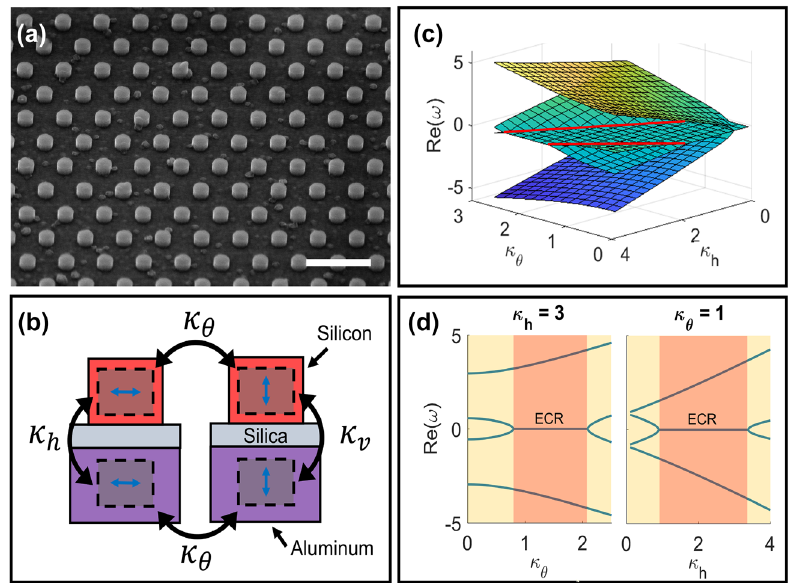
Figure 1: Ground plane system: coupling between horizontal and vertical modes unlocks topological effects. (a) Scanning electron microscope image of non-Hermitian metasurface (scale bar: 1 μ m). Silicon nanocylinders (radius = 120 nm, height = 120 nm) are arranged in a hexagonal lattice (lattice constant = 600 nm) on a silica spacer layer (variable thickness) and aluminum layer. (b) The metasurface contains horizontal and vertical photonic modes coupled to their respective image charges in the aluminum ground plane ( 𝜅 Horizontal and vertical modes can couple to each other by varying the angle of incidence of excitation ( 𝜅 𝜃 ). (c) Real part of eigenvalues for representative 4 × 4 Hamiltonian of the coupled system, showing exceptional lines (marked in red). (d) Cross sections of real part of or 𝜅 𝜃 constant. The exceptional concentric ring (red, labeled) and PT-symmetric (yellow) phases are eigenvalues, holding either 𝜅 h , 𝜅 𝜃 ) accessible by varying either parameter ( 𝜅 h